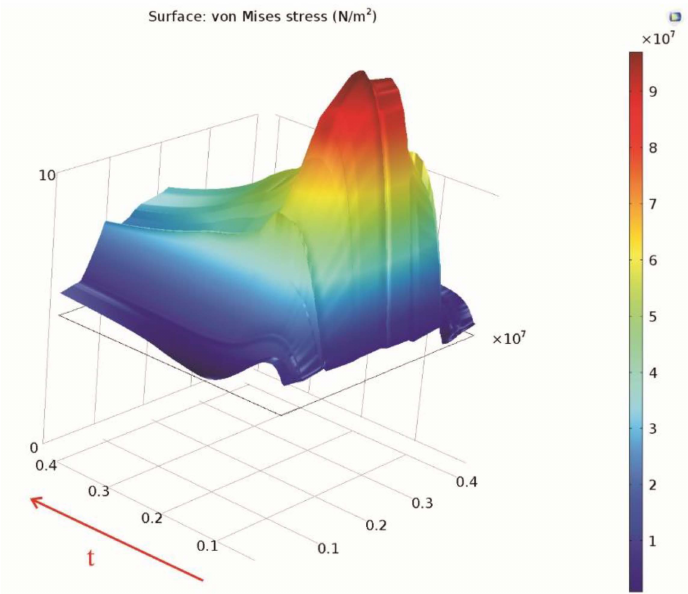
Figure 16. Variation in time of the von Mises stress along the Cut Line 3D data set.